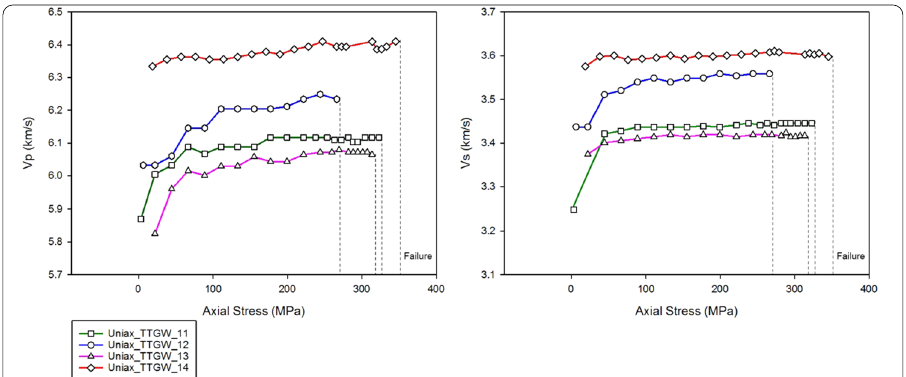
Fig. 8 Seismic wave velocities ( V p and V s ) measured along the sample axis during uniaxial compressive